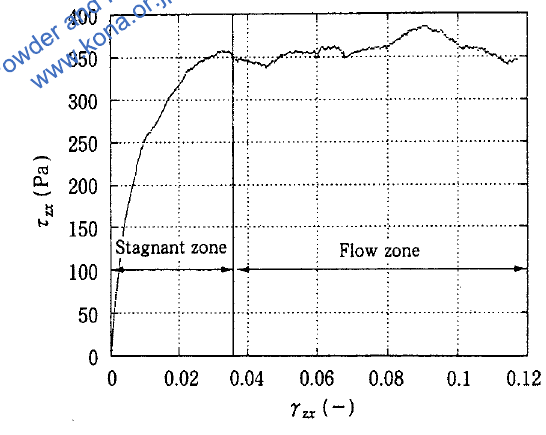
Fig. 12 . Relation between shear stress and strain